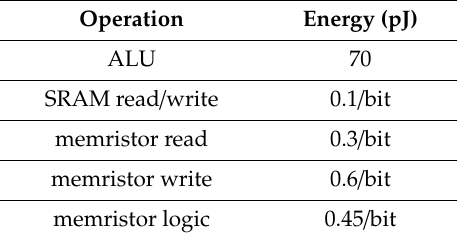
Table 5. The average energy consumption for di ff erent operations in the 28-nm